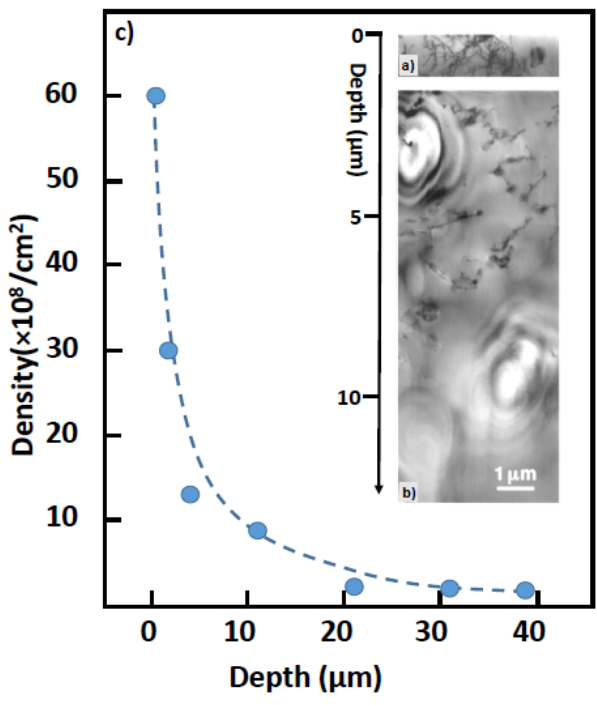
Figure 28. Hierarchical distribution of dislocations in the surface region (thickness ~30 µ m) of SrTiO 3 crystal ( a , b ) (TEM photography). The density of dislocations has been reduced from 6 × 10 9 /cm 2 ( c ) to ~10 8 /cm 2 in the deeper part of the surface region ( c ). Adapted from [10].